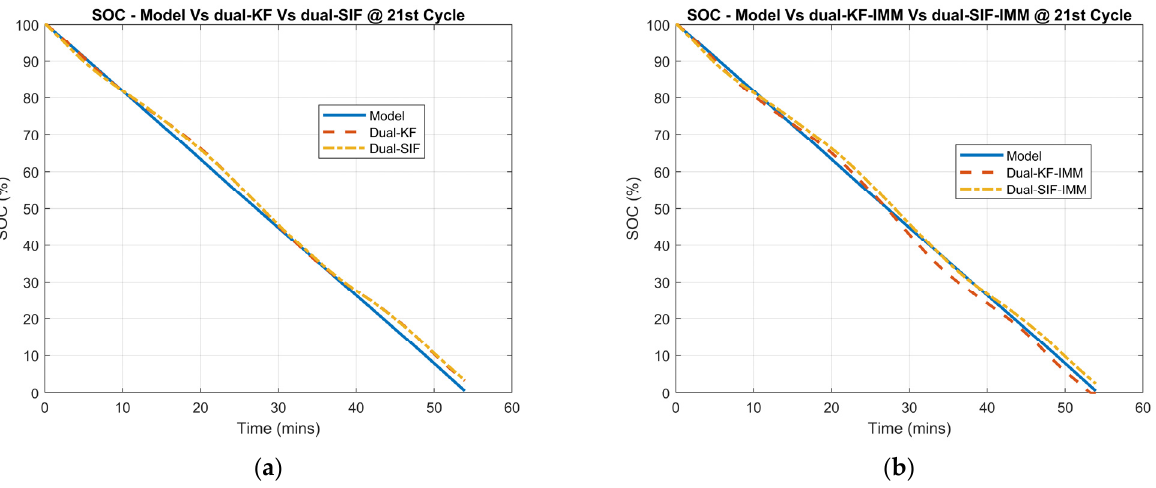
Figure 7. ( a ) Dual-KF and dual-SIF SOC estimates at cycle 21. ( b ) Dual-KF-IMM and dual-SIF-IMM SOC estimates at cycle 21.